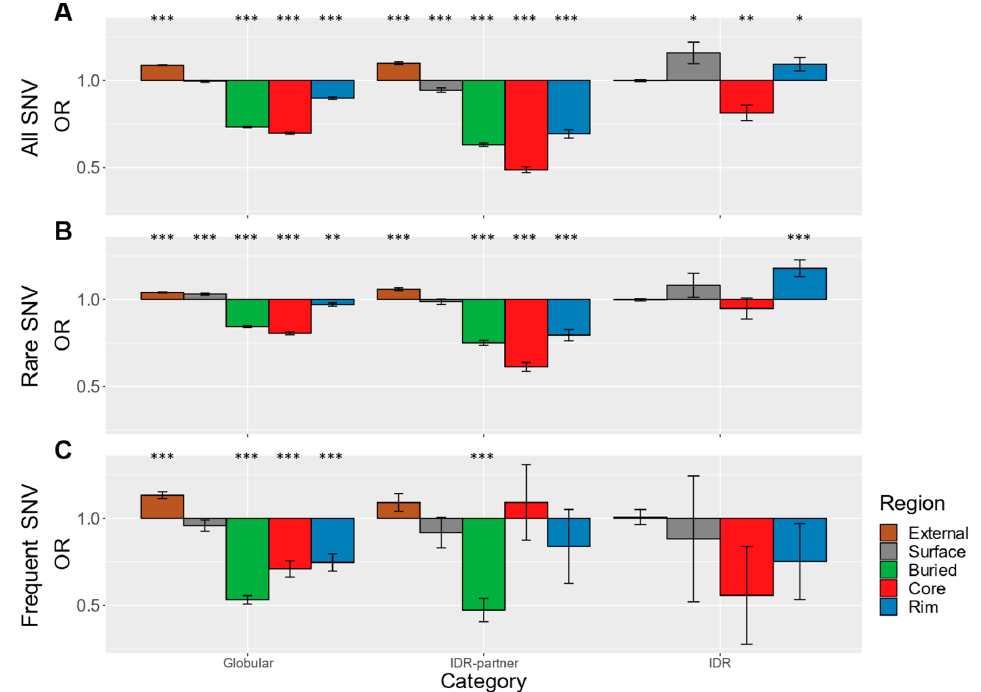
Figure 4. Odds ratios of gnomAD SNVs. ( A ) Odds ratios are calculated using gnomAD SNVs of frequencies between 0.1 to 10 − 6 . ( B ) Odds ratios are calculated using gnomAD SNVs of frequencies between 5 * 10 − 6 to 10 − 6 , i.e., rare SNVs. ( C ) Odds ratios are calculated using gnomAD SNVs of